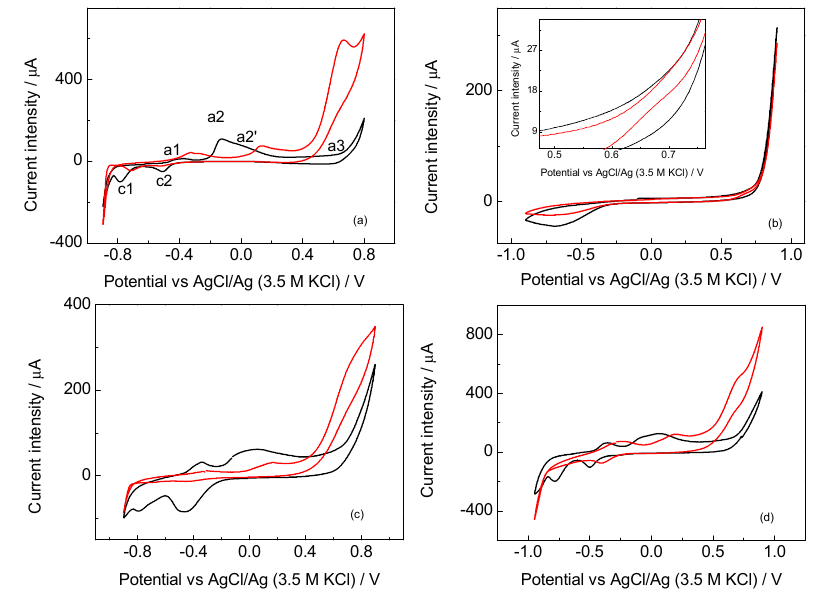
Figure 5. Cyclic voltammograms of the electrochemical response of the ( a ) Cu rod; ( b ) Nafion/SCu; ( c ) Nafion/CMCu; and ( d ) Nafion/CMCuGr in 0.1 M NaOH (black line) and in the presence of 0.02 M PGA (red line). 40 wt.% Nafion ionomer in the catalytic inks. Third scan recorded. Scan rate 10 mV s − 1 . Inset figure: SCu voltammogram ranges from 0.3 V to 0.8 V, positive scan